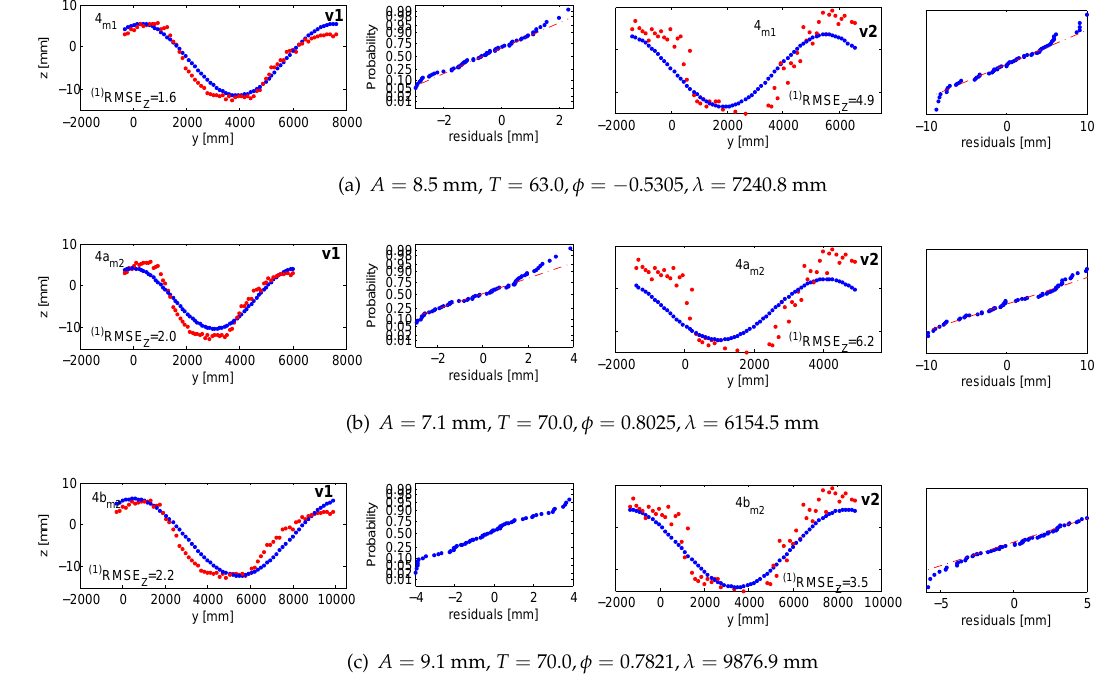
Figure 16. Accuracy 1 validation results in fourth measurement series for m 1 in ( a ) and m 2 in ( b ) and ( c ), compared against the response of vt 1 and vt 2. Ground truth in red; fitted wave model in blue. The normal probability plots are in even